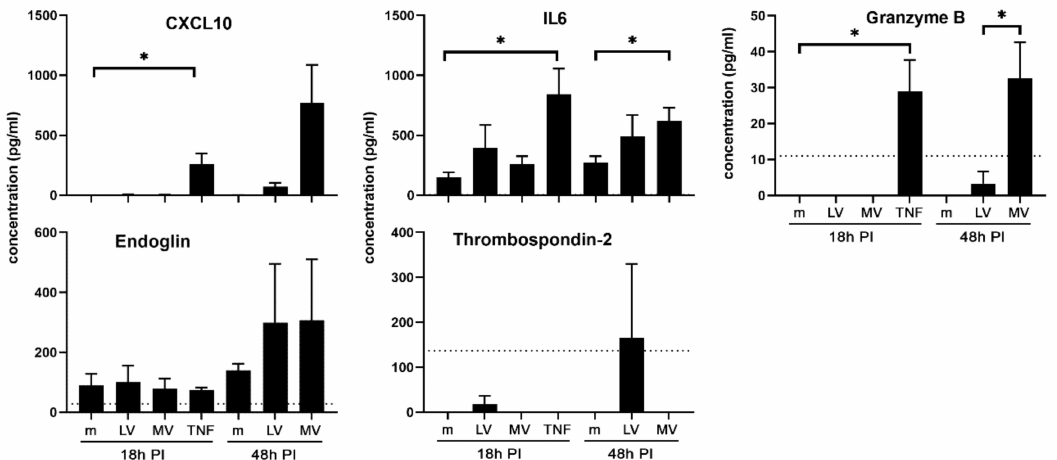
Figure 5. Quantification of mediators in the supernatants of infected HUVECs. Several mediators were quantified in the supernatants of uninfected HUVECS or HUVECs infected with LASV or MOPV 18 and 48 h after infection. Supernatants of TNF α -stimulated HUVECs were used as a positive control. Results are expressed in pg/mL as the mean ± SEM from three different cell donors. Asterisks represent significant differences ( p < 0.05) between different conditions by a t -test. The dotted lines indicate the limit of detection of the